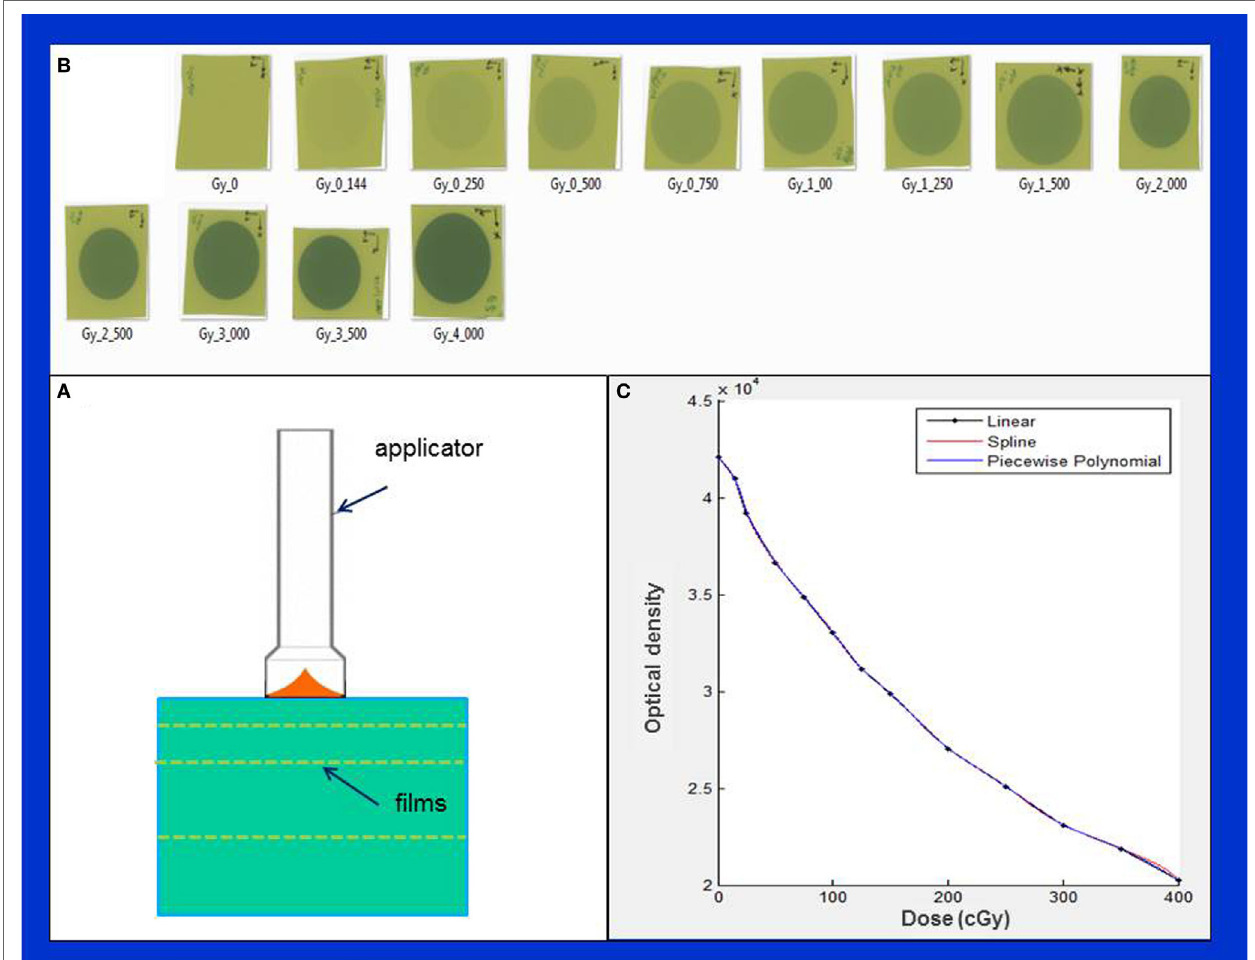
FigUre 3 | Determination of film sensitometric (H&D) curve. (a) Measurement setup showing X-ray source, phantom slabs, and EBT3 films; (B) a batch of EBT3 films irradiated in the dose range: 0–400 cGy; (c) H&D curve showing variation of film optical density with